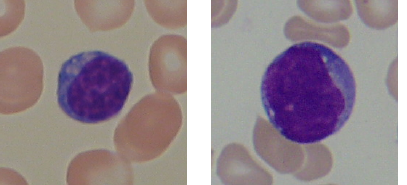
Figure 2. WBC categories from ALL-IDB2: healthy lymphocyte ( left ) and lymphoblast ( right